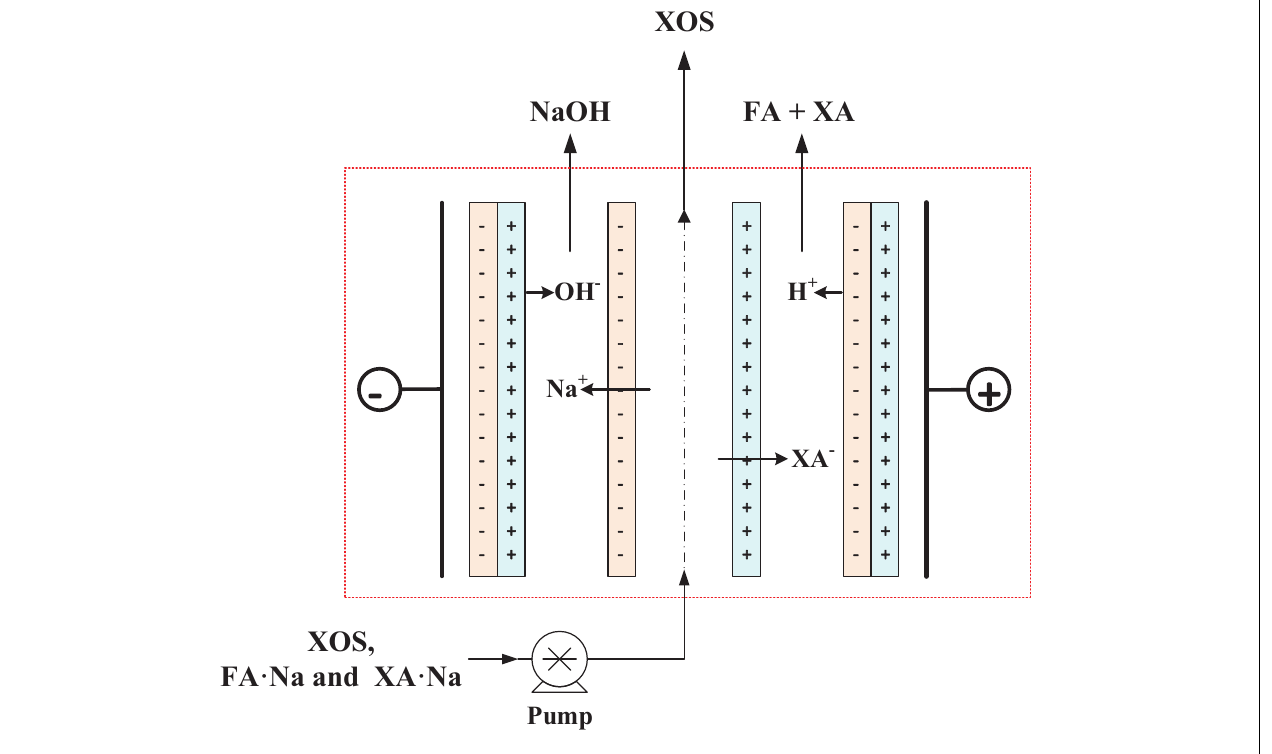
FIGURE 5 | Schematic of bipolar membrane electrodialysis for FA and XA separation. XA, xylonic acid; FA, furoic acid.